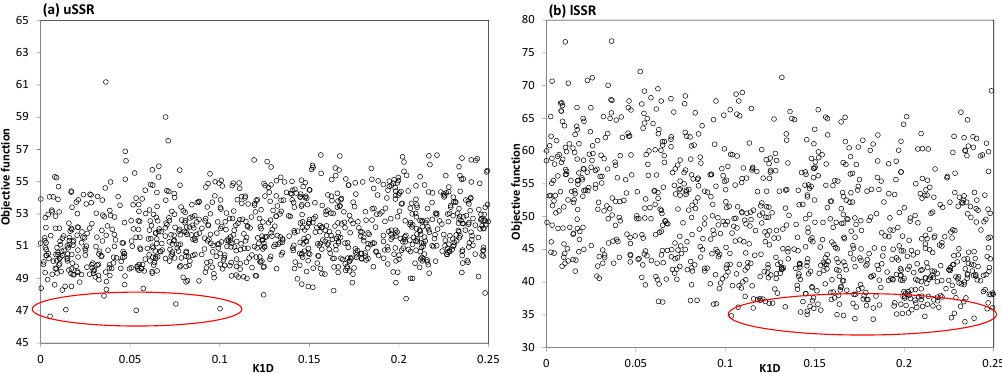
Figure 6. Dot plots of parameter sets and objective functions for K1D. ( a ) uSSR; ( b ) lSSR. Table 4. Parameter ranking in order of significance and the optimal ranges.